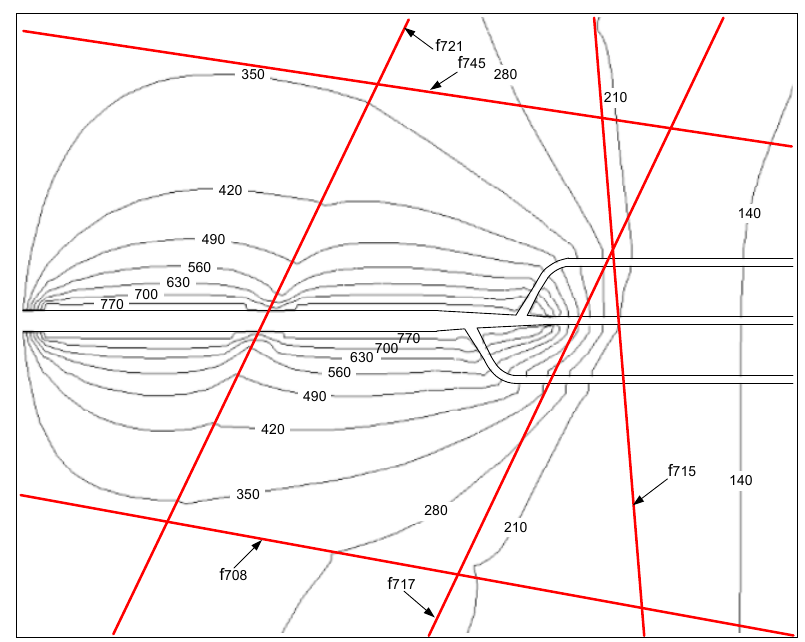
Figure 8. Phreatic surfaces and pressure distribution in the surrounding rocks at cross-section II-II.